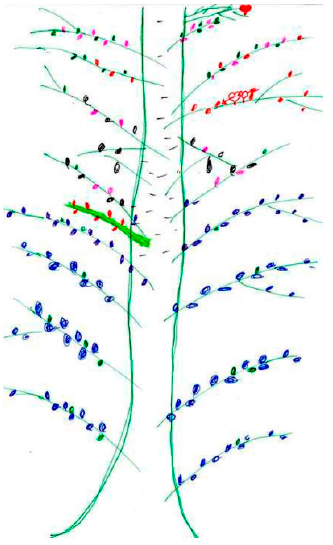
Figure 2. Sarah’s drawing.